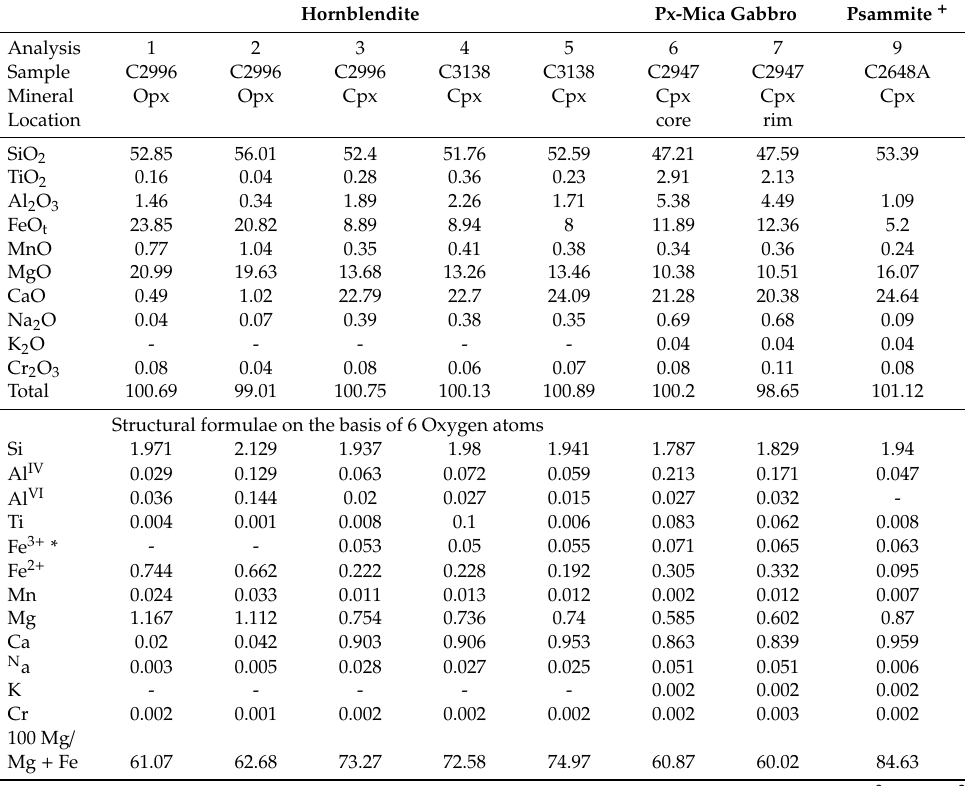
Table 3. Representative analyses of the pyroxenes by electron microprobe.